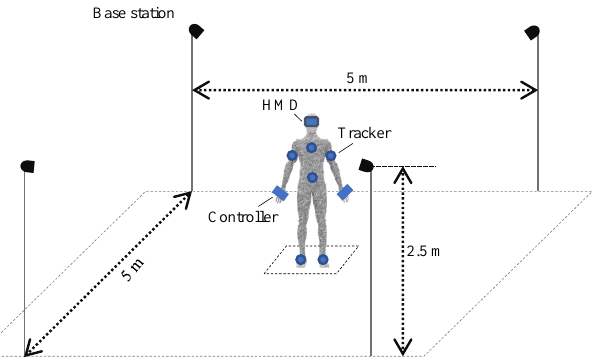
Figure 2. The HTC Vive measurement setup with four base stations and a centrally placed test person with an HMD, two controllers and six trackers.